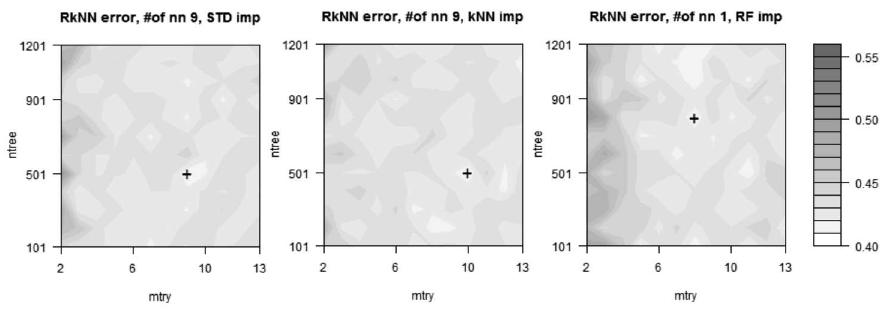
Figure 6. Results for RkNN